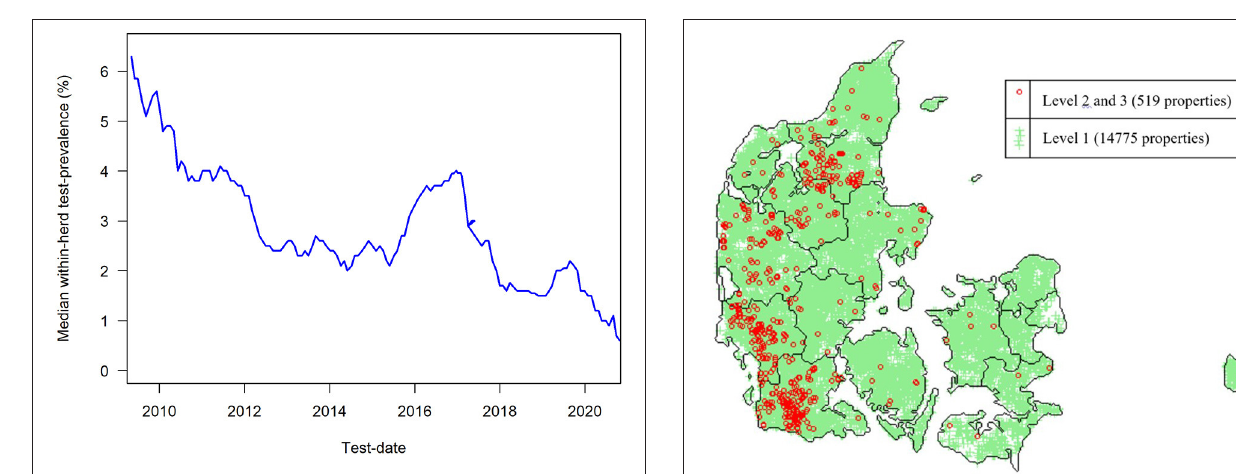
Blood samples used for BVDV testing are partly used for the S